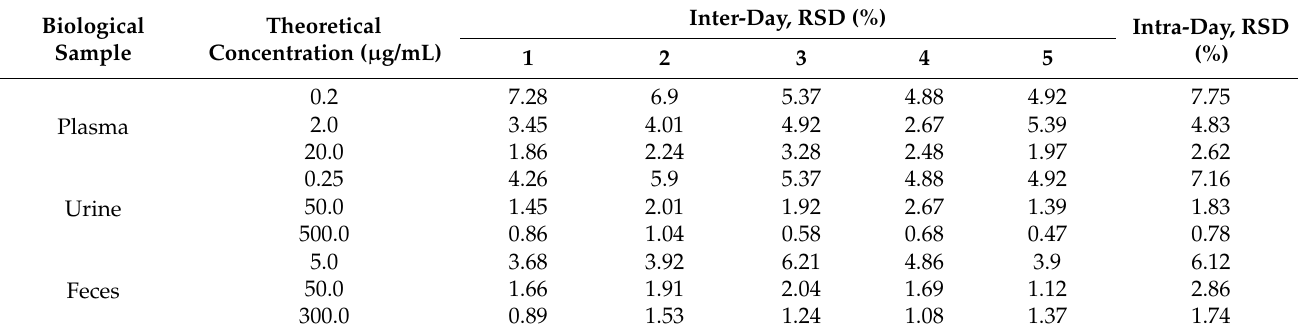
Table 1. Inter-day and intra-day precision of LBP-FITC in blank rat plasma, urine, and feces ( n = 5). Biological